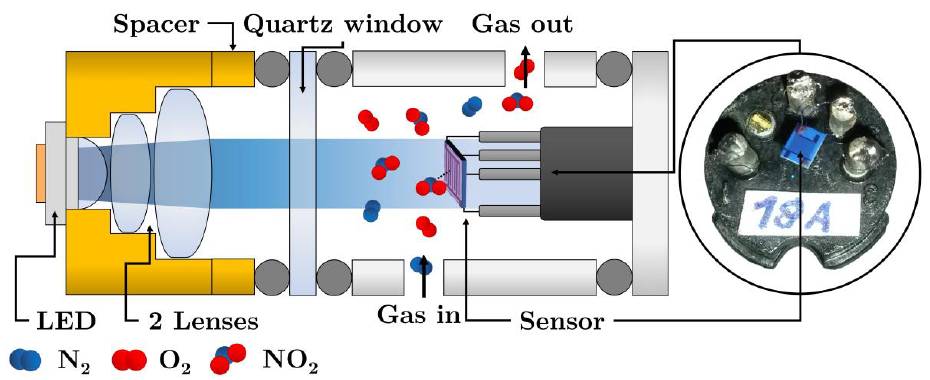
Figure 2. The arrangement of photoregeneration